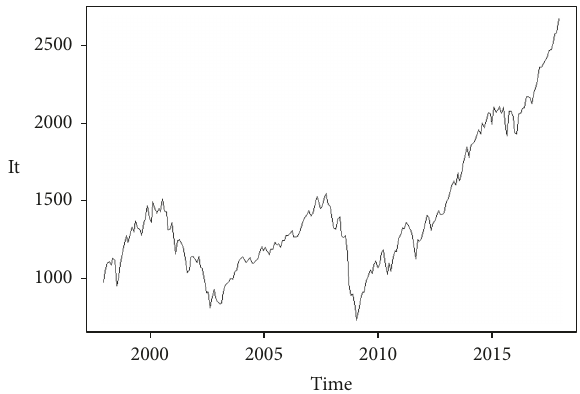
Figure 3: Overview of the monthly S&P 500 (1998-2017).